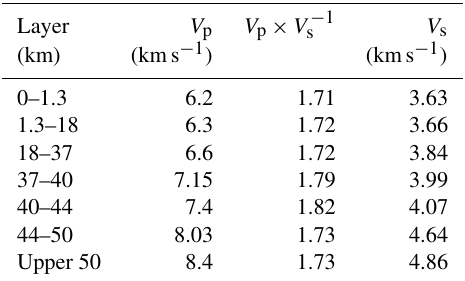
Table 1. 1-D P wave and S wave velocity